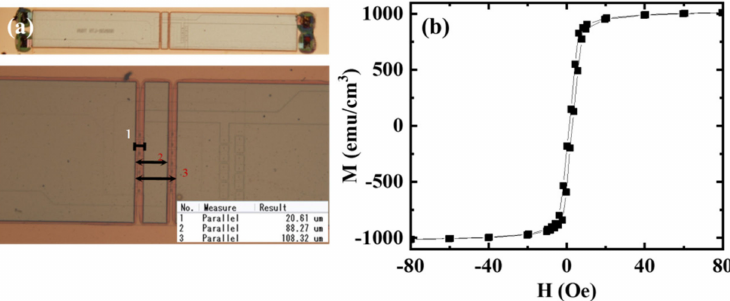
Figure 4. ( a ) Microscope image of the MTJ sensor with the double-gap MFC, ( b ) hysteresis loop of the soft NiFe